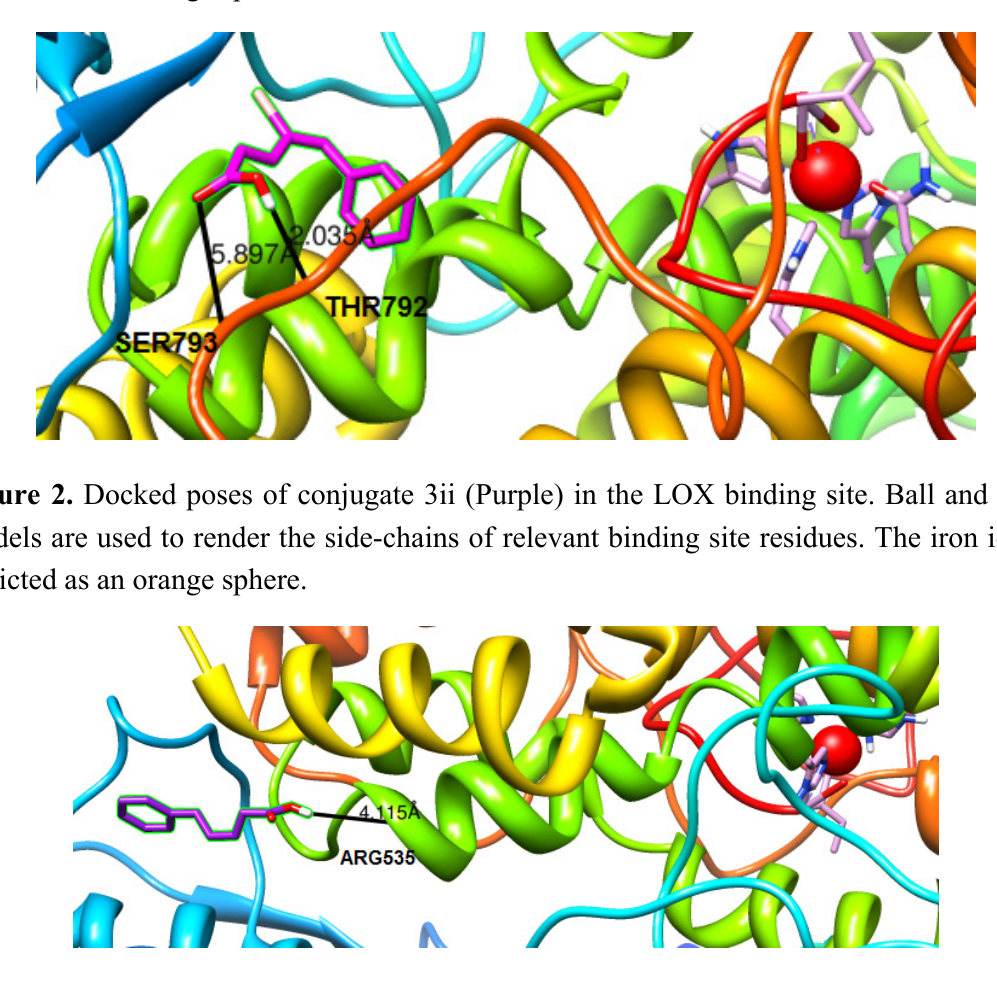
Figure 1. Docked poses of conjugate 4ii (Magenta) in the LOX binding site. Ball and stick models are used to render the side-chains of relevant binding site residues. The iron ion is depicted as an orange sphere.